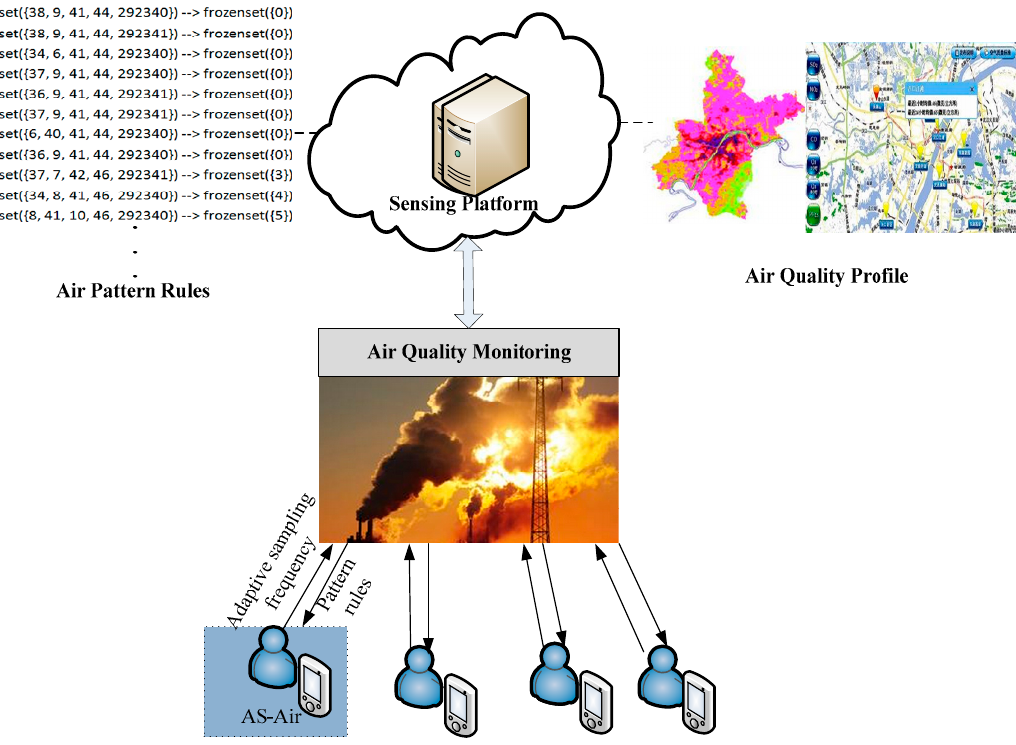
Figure 1. Participatory Sensing System for Urban Air Quality Monitoring.